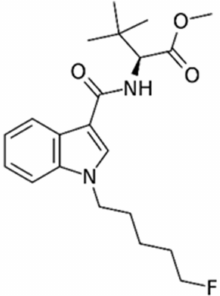
Figure 1. Chemical structure of 5F-MDMB-PICA [Methyl (S)-2-[1-(5-fluoropentyl)-1 H -indole-3- carboxamido]-3,3-dimethylbutanoate